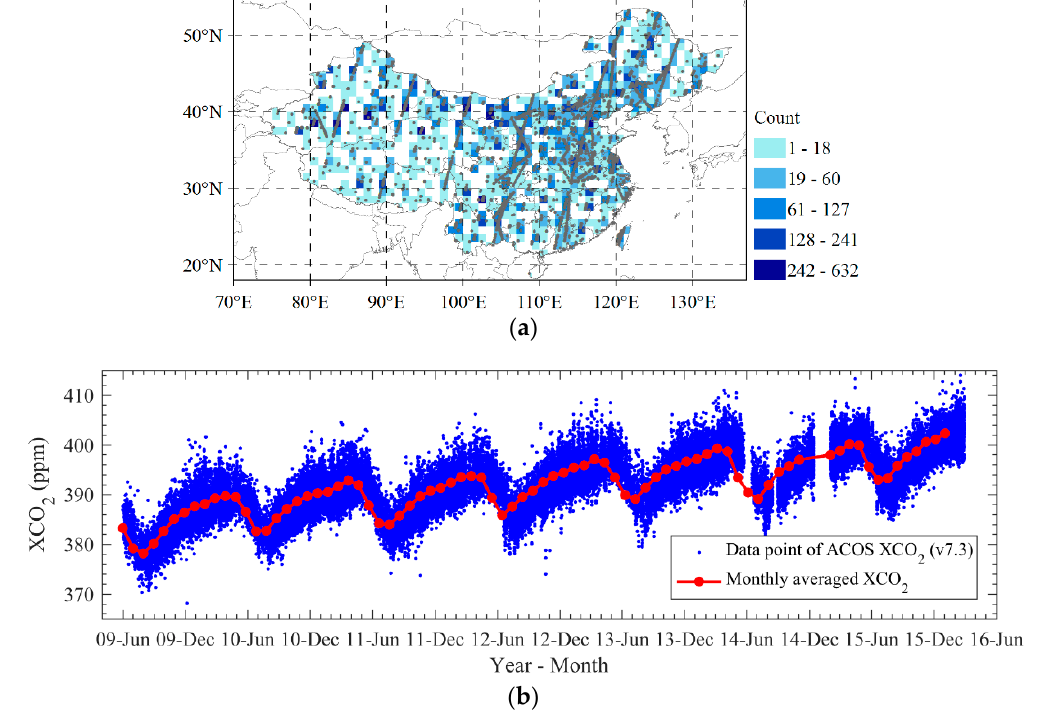
Figure 1. Number of available retrievals and temporal changes of collected XCO 2 data: ( a ) the number of XCO 2 data points within 1° × 1° grid for 6 years from 2010 to 2015; ( b ) the temporal variation of XCO 2 and the monthly averages.